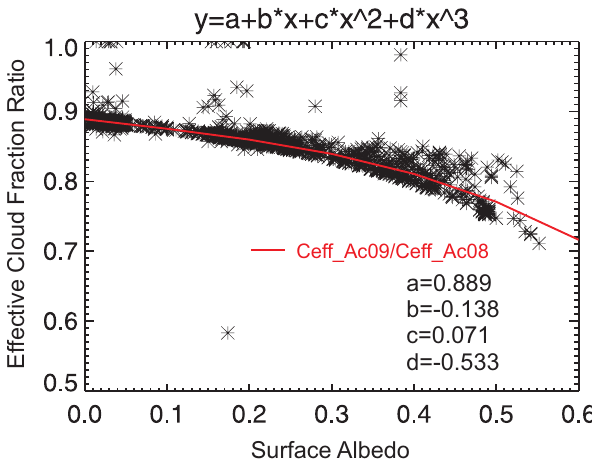
Fig. 8. Ratio of FRESCO+ effective cloud fractions for an assumed cloud albedo of 0.9 and 0.8, respectively. Based on FRESCO+ retrievals from one SCIAMACHY orbit (4 February 2007,